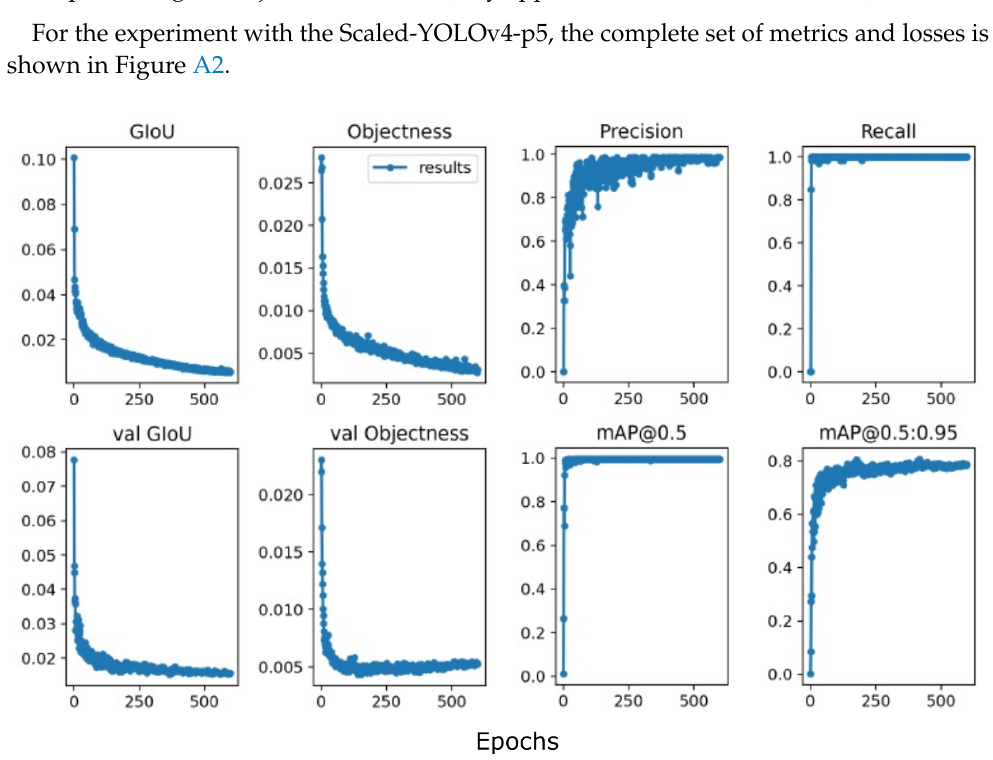
Figure A2. Training losses and metrics for the Scaled-YOLOv4-p5 trained on the iCubWorld dataset (see Section 3.3) for 200